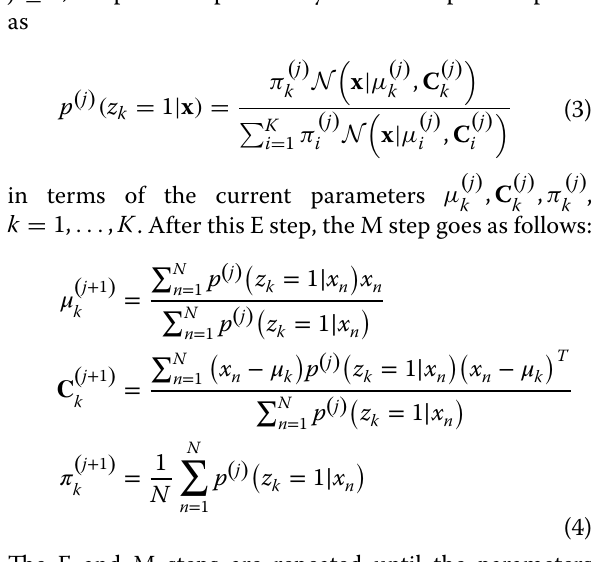
Fig. 1. The key idea is to perform computational optimiza-